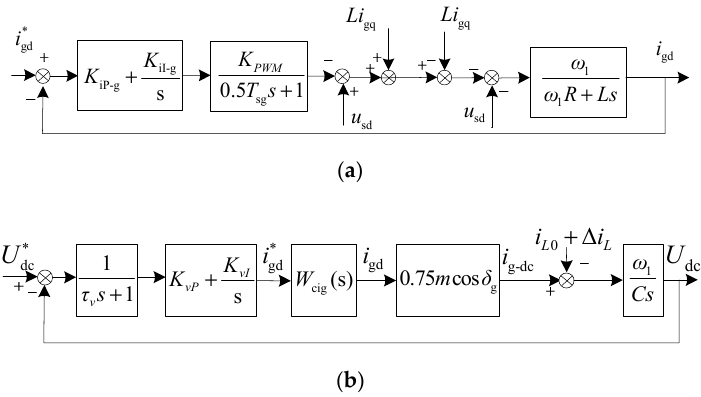
Figure 1. Current regulating loop and voltage regulating loop of the grid-side converter (GSC): ( a ) current regulating loop; ( b ) voltage regulating loop.